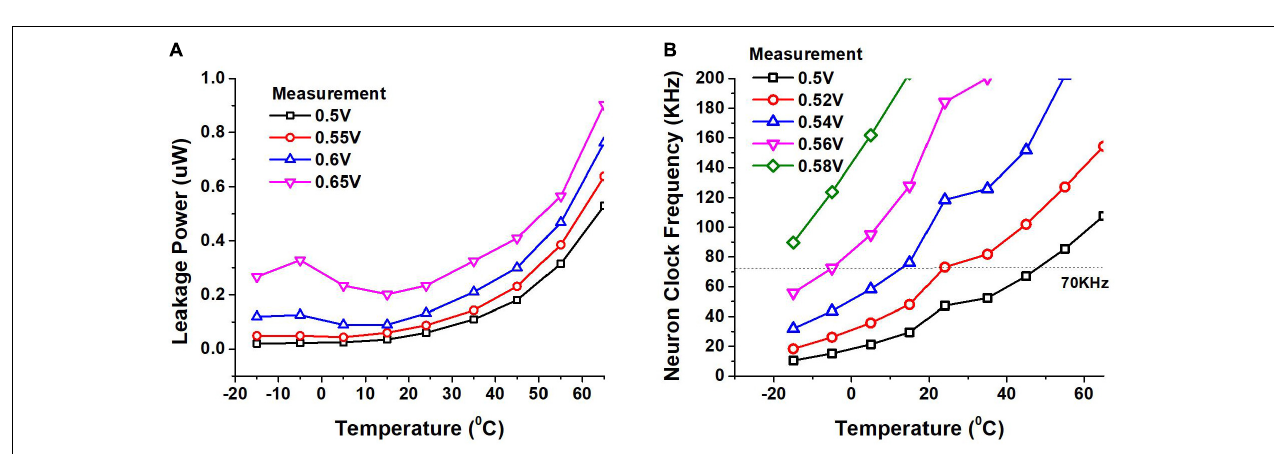
FIGURE 11 | (A) Accuracies of the SNN chip measured across multiple benchmarks. (B) ROC curves from KWS benchmarks obtained using RTL simulation. (C) Accuracy of the SNN chip on KWS datasets across 0–40 dB SNR levels obtained using RTL simulation. (D) Measured power consumption of chip and error for the HeySnips dataset as a function of activation precision. Stars denote the operating point used for comparison with other works.